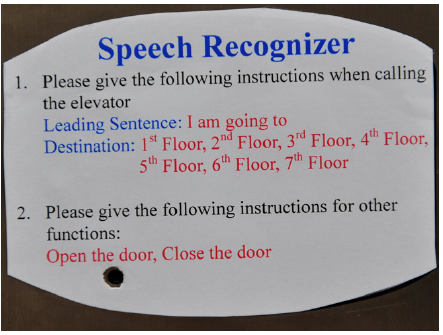
Figure 16. Instruction label of speech recognizer and sound hole.